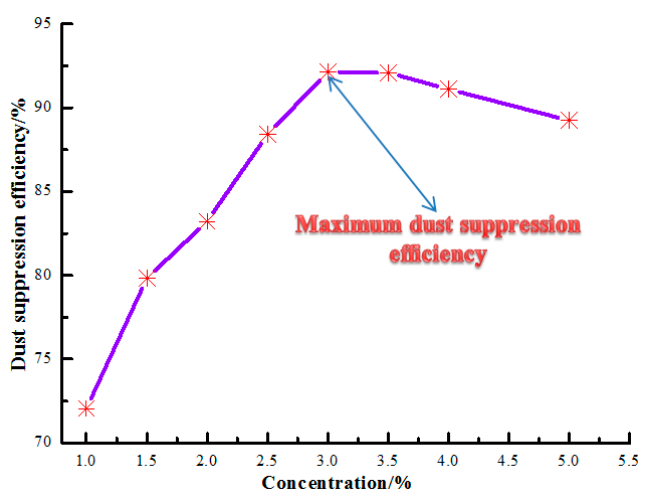
Figure 8. Dust suppression efficiency of sodium dodecyl sulfonate-soybean protein isolate (SDS-SPI) cementing dust suppressants.